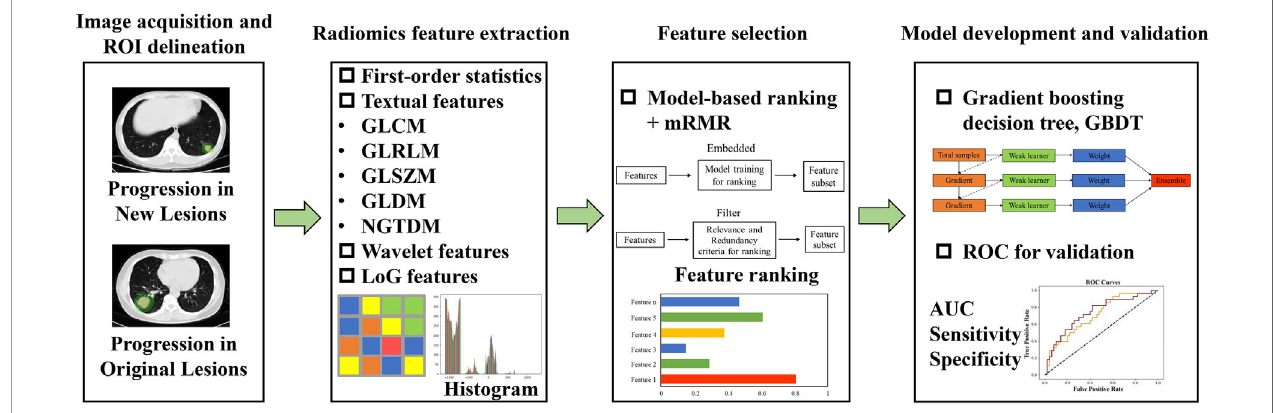
FIGURE 1 | The work fl ow of our study. It consists of four steps: image acquisition and preprocessing, radiomic features extraction, features selection, and the classi fi cation model development and